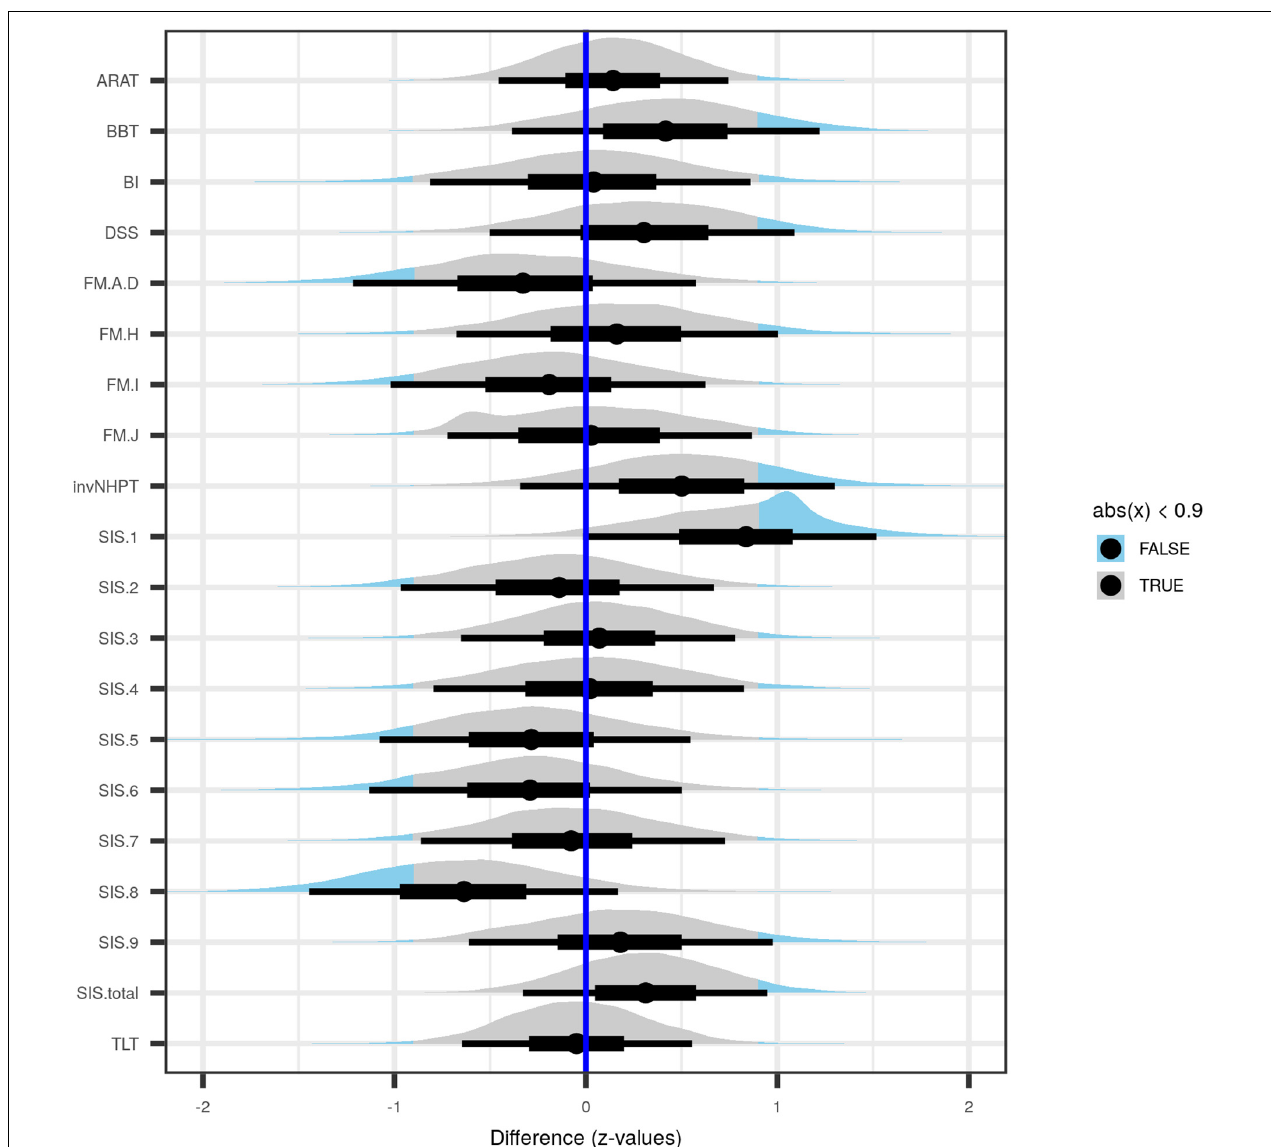
FIGURE 1 | Posterior distributions of differences between treatment and control groups of the tested variables, each along with median point estimate (dot), 50 percent uncertainty interval (thick black horizontal bar), and 90 percent uncertainty interval (thin black horizontal bar). The part of a given distribution further than 0.9 standard deviations away from zero is shown in light blue instead of in gray. Point estimates > 0 represent higher initial scores in the treatment group, while values < 0 imply larger initial scores in the control group. ARAT, Action Research Arm Test; BBT, Box and Block Test; BI, Barthel Index prior to begin of rehabilitation; DSS, number of days elapsed between ocurrence of stroke and commencement of rehabilitation; FM.A-D, Fugl-Meyer test subscales A–D, covering reflexes, volitional movements, wrist and hand function and the coordination of the upper extremity; FM.H, tactile sensation in the affected and non-affected extremity; FM.I, passive joint motion; FM.J, passive movement joint pain; invNHPT, (inverted) Nine-Hole Peg Test; SIS.1, physical problems as a result of the stroke; SIS.2, memory and thinking abilities; SIS.3, mood and emotions; SIS.4, communicational skills in speaking, reading and writing; SIS.5, impairment of daily activities; SIS.6,